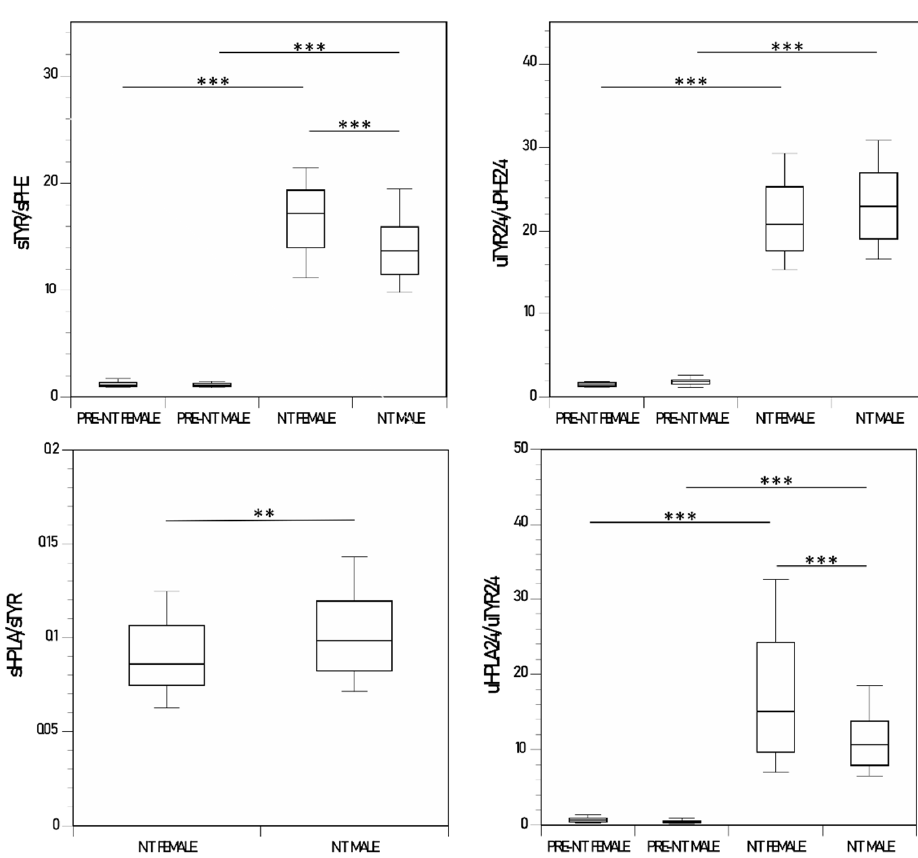
Figure 4. Changes in sTYR/sPHE and uTYR 24 /uPHE 24 , and sHPLA/sTYR and uHPLA 24 /uTYR 24 , in the nitisinone group of the SONIA 2. ( p -values indicated for comparison between female pre-nitisinone (n = 24), male pre-nitisinone (n = 45), female nitisinone (n = 120), male pre-nitisinone (n = 225), sampling points where statistical significance was achieved) (data shown as boxplots with median) (statistical significance p expressed * < 0.05, ** < 0.01 and *** < 0.001, respectively). sHPPA/sTYR ratio was not available pre-NIT as the HPPA was below the LLoQ; however, during NIT therapy there was a trend towards a higher sHPPA/sTYR ratio in the male group compared with the female group. The uHPPA 24 /uTYR 24 ratio was signifi- cantly higher during NIT therapy than prior to NIT therapy in both the male and female